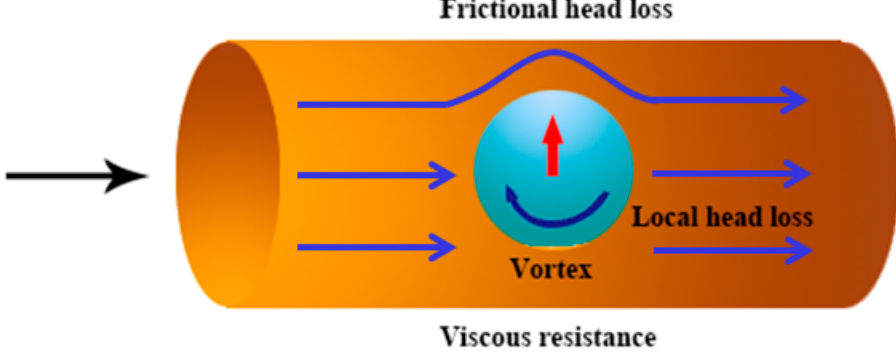
Figure 4. Diagram of frictional head loss and local head loss while flowing.